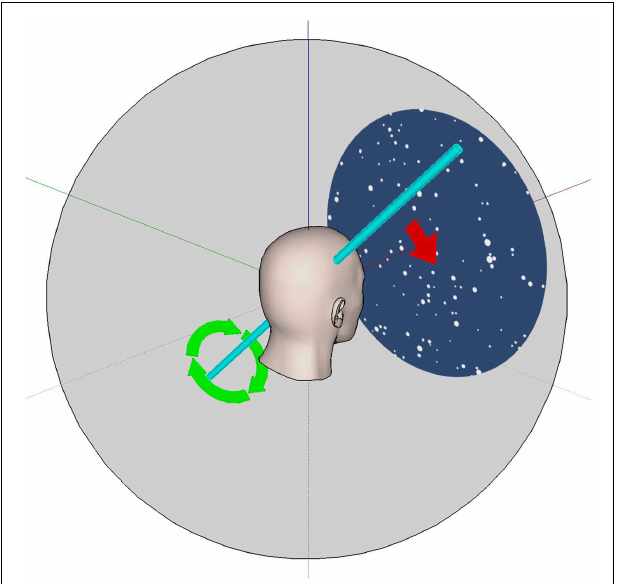
FIGURE 1 | The VR optokinetic stimulus in an oblique plane . The white dots visible to the subject appear to move as if they were attached to a sphere (gray) that rotates about an oblique axis. This axis (shown in light blue) is halfway between the Y (pitch) and Z (yaw) head axes; all axes here are attached to (i.e., they move with) the head. For example, positive rotation (in the direction of the green arrows) about the light blue axis leads to dots which appear to move diagonally down and to the right (red arrow). Negative rotation about this axis leads to dots that move up and to the